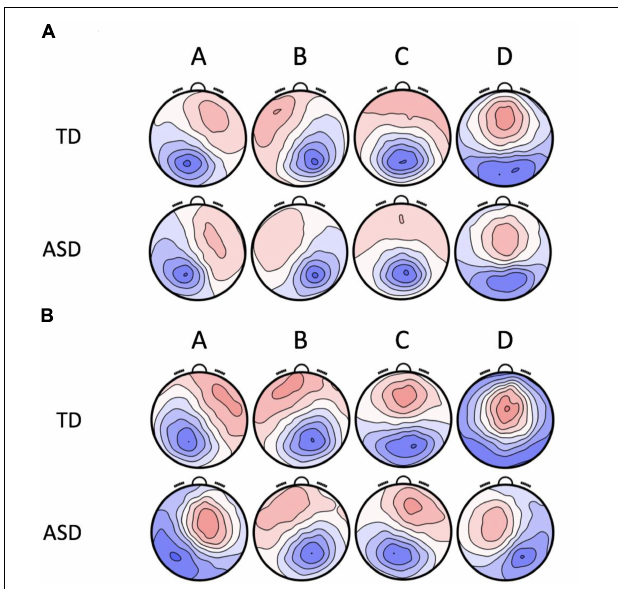
FIGURE 1 | The group-level maps of the four microstate classes (A–D) in ASD and TD, independently computed for the two resting-state conditions.